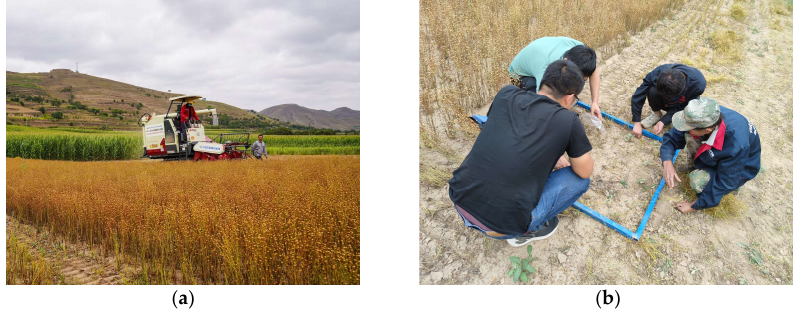
Figure 12. Field test: ( a ) Field operation of the tester apparatus. ( b ) Field testing of operational effectiveness. Table 2. Factor-level coding table.